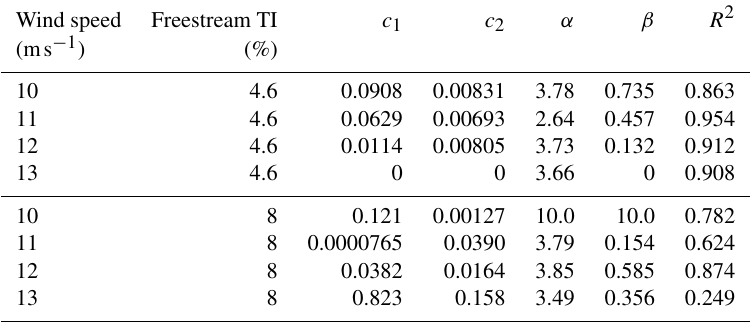
Table 2. Tuning constants for the velocity data shown in Fig.